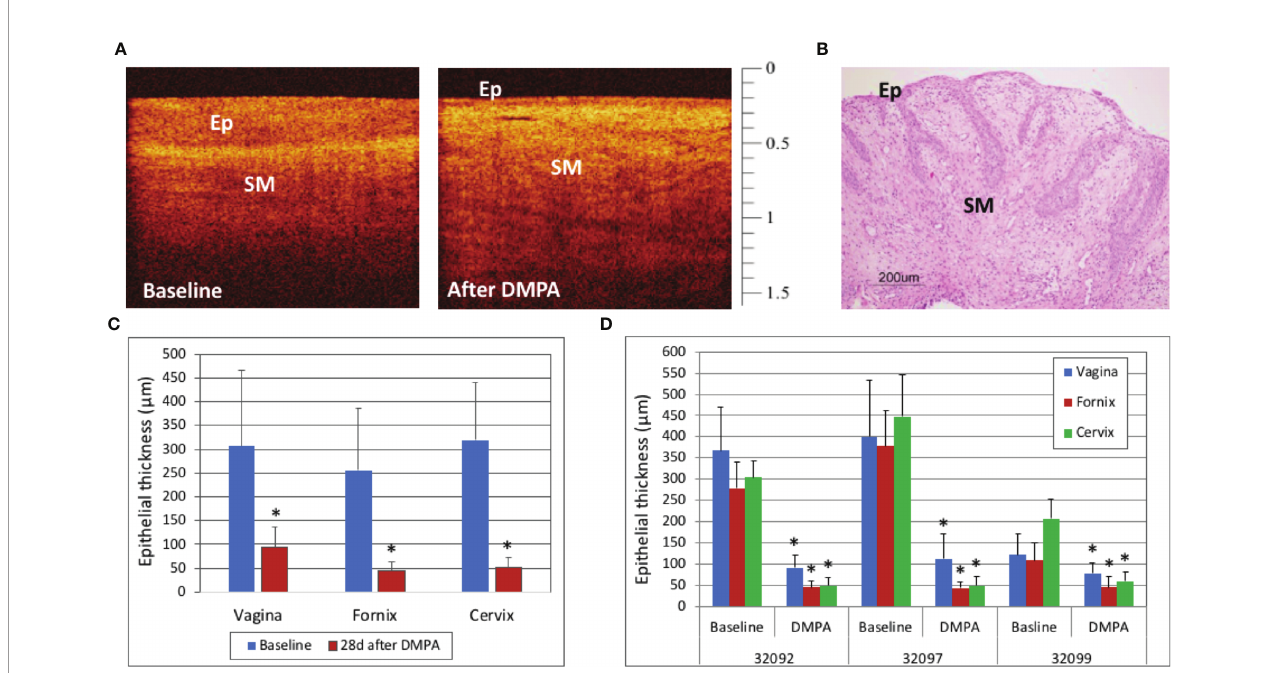
FIGURE 5 | Optical Coherence Tomography (OCT) and Histology Findings after Depomedroxyprogesterone Acetate (DMPA) Treatment – Vaginal epithelial thinning after DMPA could be visualized with OCT imaging ( A , OCT calibration bar is in mm, with small tick mark = 100 m m) as well as hematoxylin and Eosin (H&E) staining from a vaginal biopsy ( B , H&E scale bar = 200 m m). Cervicovaginal epithelial thickness measured by OCT before and 28 days after DMPA treatment showed that DMPA signi fi cantly thinned epithelium at all anatomic sites ( C , p<0.001), and while there was variability between animals at baseline, the epithelial thickness (ET) was decreased at all sites in all animals after DMPA ( D , p<0.001 for all comparisons). Error bars indicate standard deviation and asterisks (*) indicate signi fi